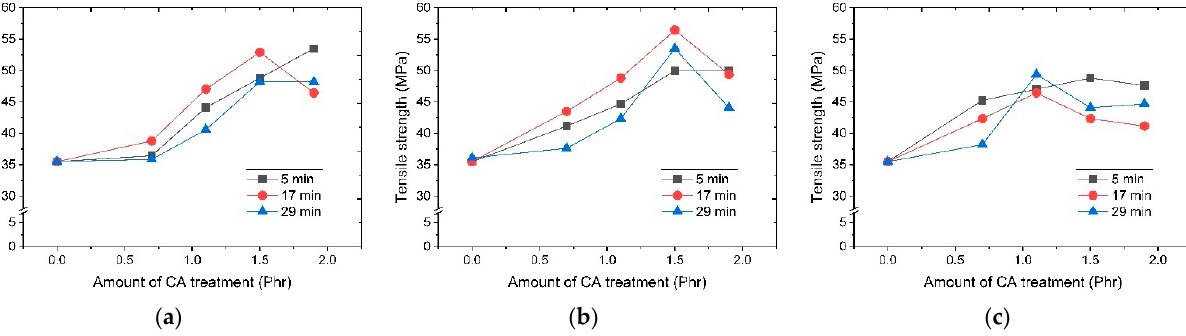
Figure 4. Tensile strength depending on surface modification temperature and CA addition amount: ( a ) 130 °C; ( b ) 150 °C; ( c ) 170 °C.